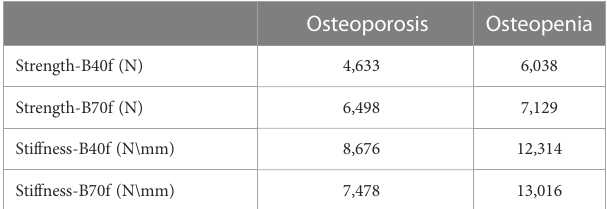
TABLE 2 Cutoff value for osteoporosis and osteopenia by FEA based on smooth standard kernel (B40f) and sharp bone kernel (B70f)